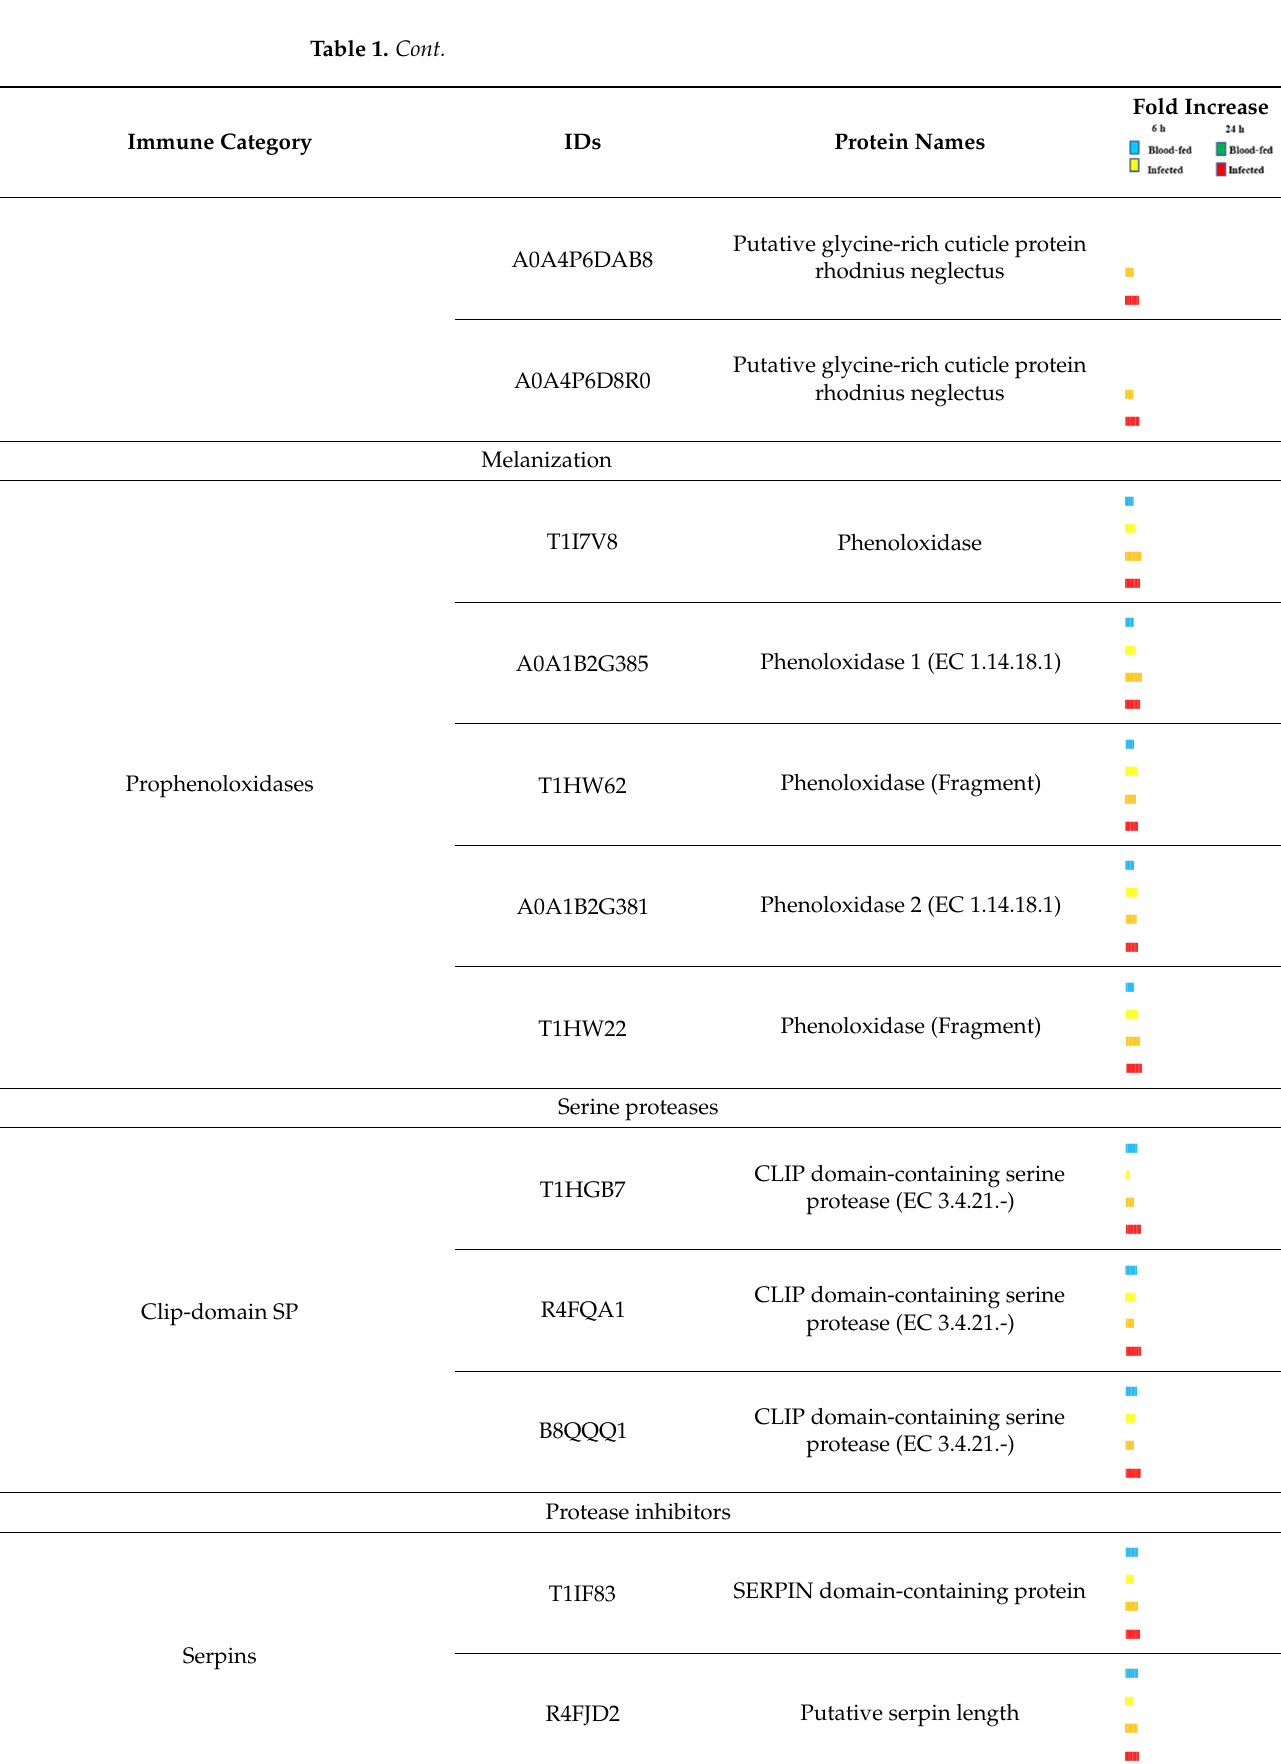
Table 1. Expression pattern of immunity related proteins identified in R. prolixus